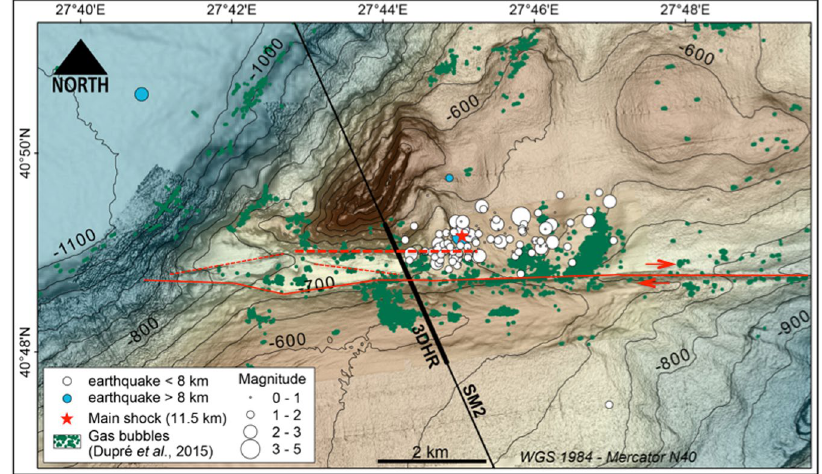
Figure 4. Epicenter locations for the aftershocks that followed the M 5.1 earthquake of July 25, 2011, superposed on a high-resolution bathymetric grid derived from a combination of near-seafloor AUV data 37 and on an unpublished, bathymetric grid having a resolution of 10 m, based on data collected in 2014 during the Marsite cruise of R/V Pourquoi pas?. White and blue dots are respectively epicenters within and below the sedimentary basin. Green dots indicate the location of the gas emission that were acoustically detected 22 in 2009, using the multibeam echasounder EM302 of R/V Le Suroit. Note that there is no clear overlap between the seismicity (from 2011) and seafloor gas emissions (detected in 2009), e.g. there is no direct evidence that the ultra-shallow aftershocks of 2011 directly induced gas emissions in the water column. Thin black line indicates the track of the seismic section displayed in Fig. 5. The thickened segment represents the location of the 3D, High-Resolution seismic image shown in Fig. 6. The continuous red line indicates the trace of the right-lateral, strike-slip, Main Marmara Fault. Red dotted lines show secondary faults indicating the complexity of the fault network linked to the MMF. The thicker, east-west oriented, dotted line is also shown in the seismic section displayed in Fig. 5. Image created with Arc-GIS, version v3.0.